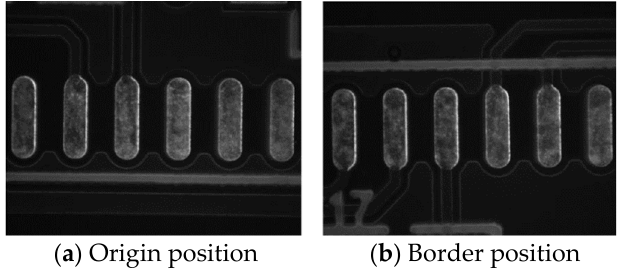
Figure 5. Images of the actual situation.